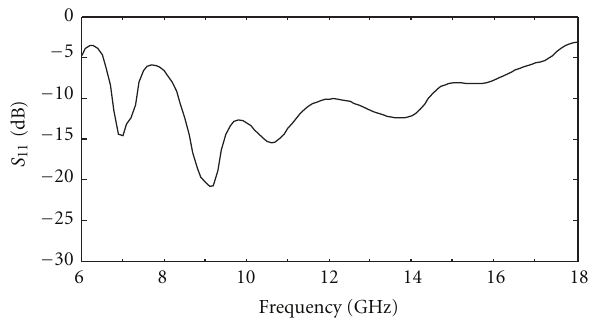
Figure 4: S 11 at the feed port for any of the four sinuous